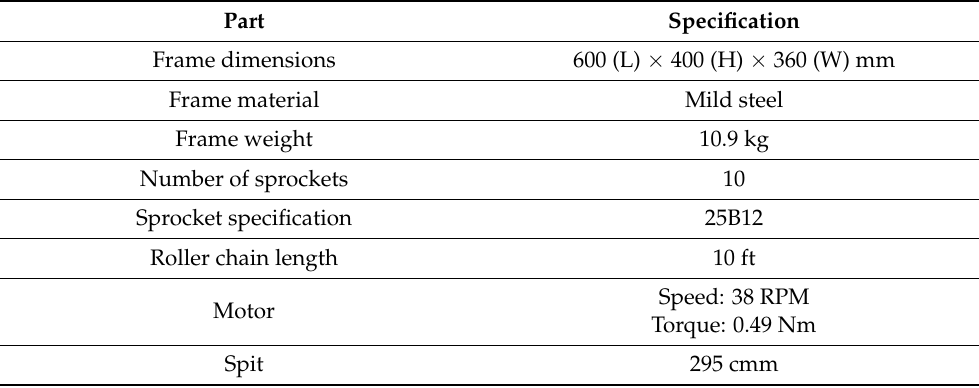
Figure 8. The rotisserie spit used for the spit ‐ roller chain engagement.